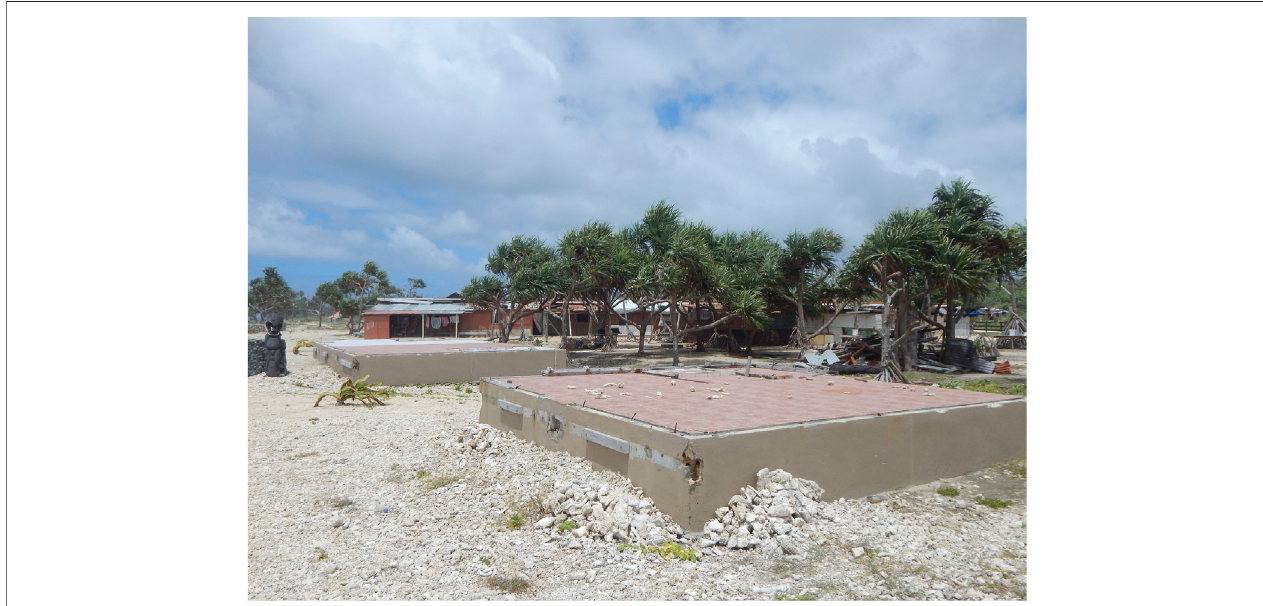
FIGURE 1 | Only the foundations remain from this beachfront resort on Efate Island after Cyclone Pam struck the area. Source: Author ’ s own.